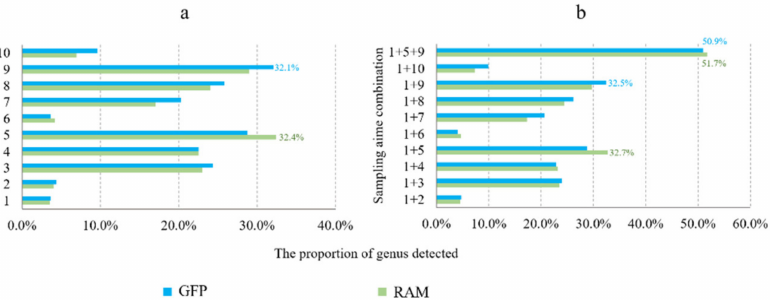
Figure 7. Genera of dormant microorganisms detected at different combinations of sampling times. ( a ) Proportion of bacterial genera detected by GFP and RAM to total genera in days 1–10; ( b ) Propor- tion of bacterial genera to total genera detected at different combinations of days within 10